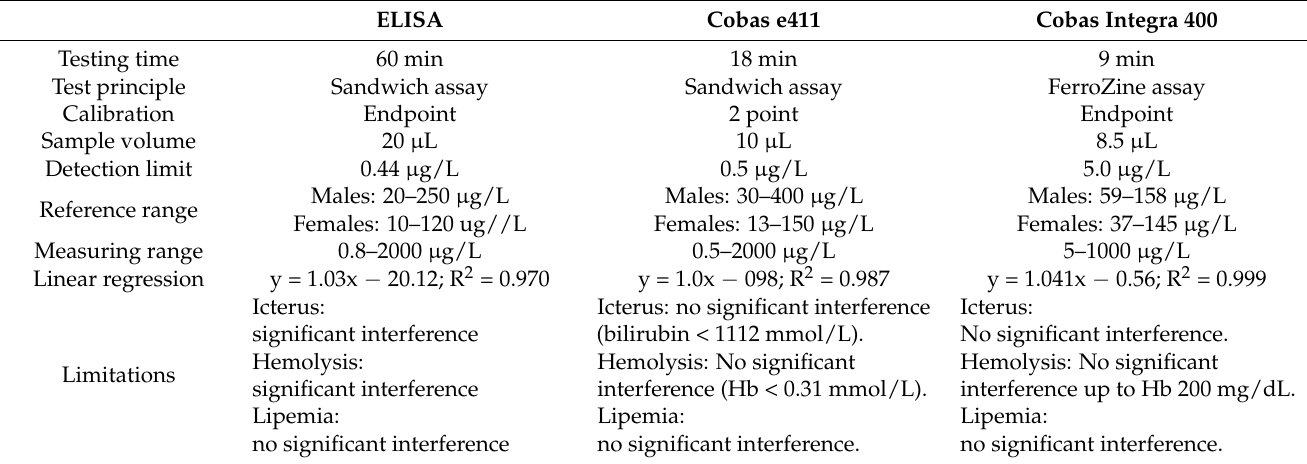
Table 1. General characteristics of the